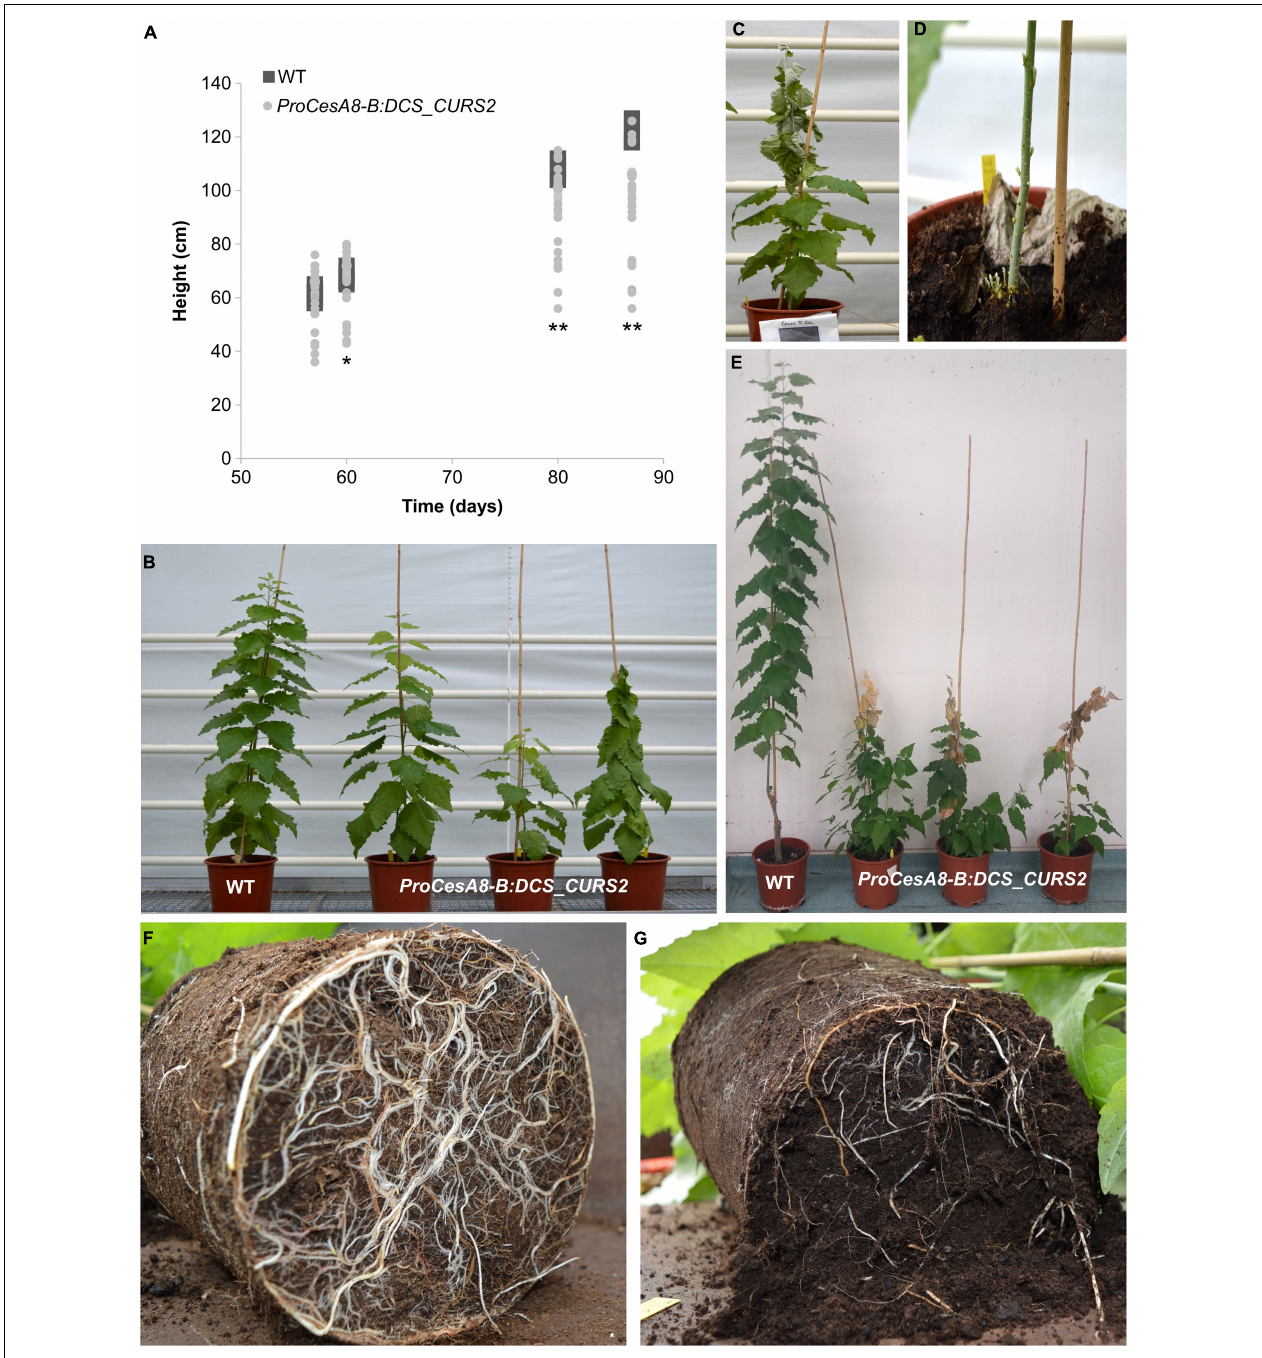
FIGURE 3 | ProCesA8-B:DCS_CURS2 poplars display growth perturbations. (A) Growth curves of WT and ProCesA8-B:DCS_CURS2 poplars over a period of 87 days. Individual values are represented by squares (WT) or dots ( ProCesA8-B:DCS_CURS2 ). Differences in growth between the WT and the transgenic lines were assessed with Student’s t -test (*0.01 < P < 0.05; ** P < 0.01; WT, n = 8 biologically independent replicates; ProCesA8-B:DCS_CUR S2, n = 28 biologically independent lines). (B) During the 87-day growth period, a lot of variation was observed in the severity of the growth perturbation of ProCesA8-B:DCS_CURS2 poplars. (C,D) After ceasing growth, the shoot tip of some transgenic poplars started to senesce (C) , after which many new secondary shoots emerged from the roots and basal part of the stem (D) . (E) Image taken after a second 4-month growth period (after pruning the poplars after their first 87-day-long growth period); the WT reached a height of approximately 2 m, at which point the tip of the main stem of the ProCesA8-B:DCS_CURS2 poplars had become necrotic at a height of approximately 1 m. However, a lot of secondary shoots sprouted from the roots and the basal part of the main stem. (F,G) The root system of ProCesA8-B:DCS_CURS2 poplars (G) was underdeveloped compared to that of the WT (F) after growing in the greenhouse for 87 days. Scale bars: 20 cm in (B,C,E) and 10 cm in (D,F,G) .